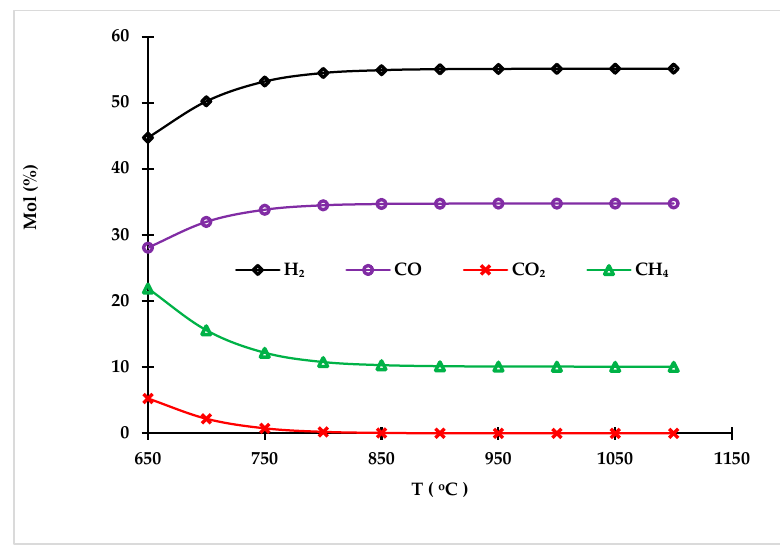
Figure 5. Effect of steam to plastic ratio on syngas composition.